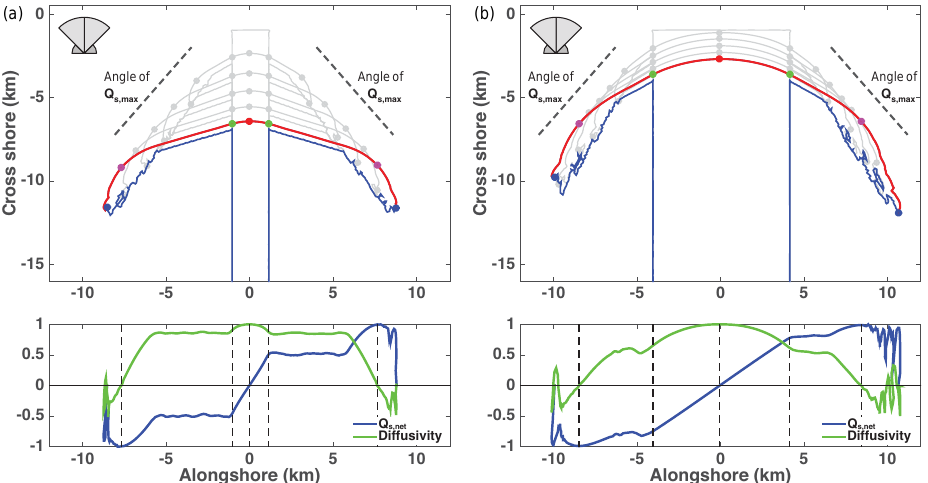
Figure 6. Spit growth with symmetrical (and identical) wave climates, but with different initial headland widths of (a) 2km and (b) 8km, after 96 model years with corresponding plots of normalized alongshore sediment transport and diffusivity ( A = 0 . 5 , U = 0 . 1).